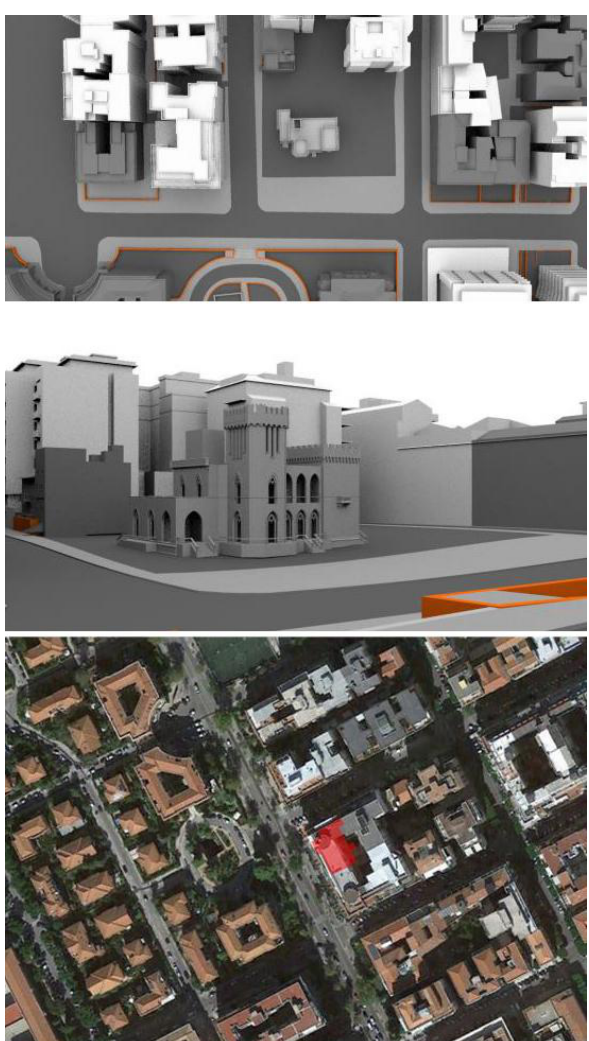
Figure 12 . Perspective reconstruction of the current area of ​ ​ interest and overall view with the inclusion of Villa